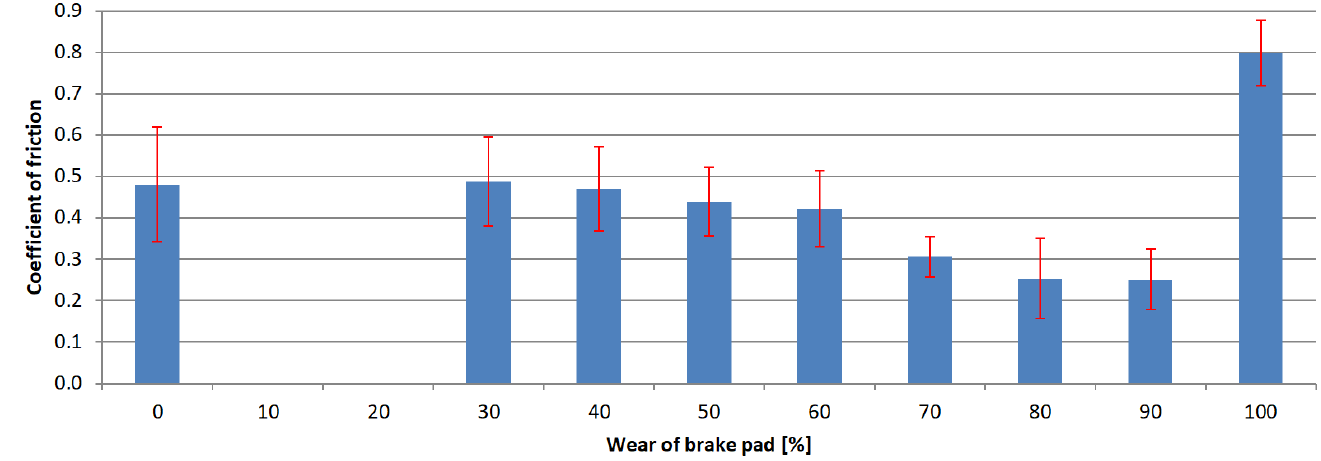
Figure 9. Coefficient of friction values of samples obtained from 4th brake pad group. The range of point errors adjacent to the results that were missing due to the una- vailability of samples allowed for an approximate interpolation. The Lagrange algorithm [40] was used for this purpose: